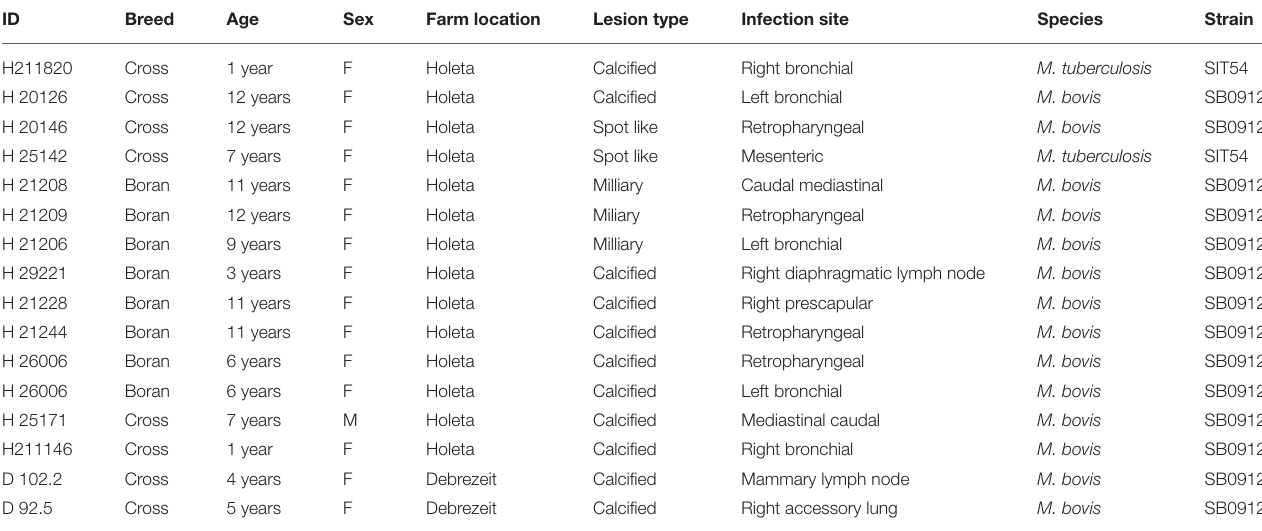
TABLE 4 | Distribution of tuberculosis lesion in the lymph nodes of single intradermal cervical comparative tuberculin test-positive animals and spoligotypes of M. bovis and M. tuberculosis isolated from the lesion.